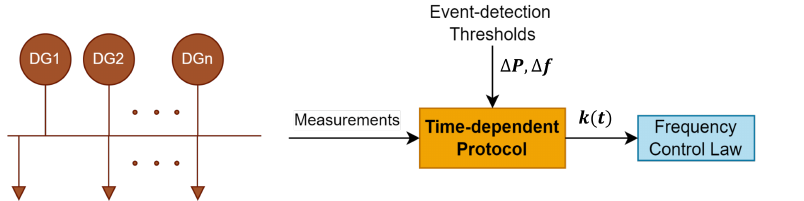
Figure 9. Diagram of the implemented secondary event-trigger controller based on generalized time-dependent protocol for singles or multiples